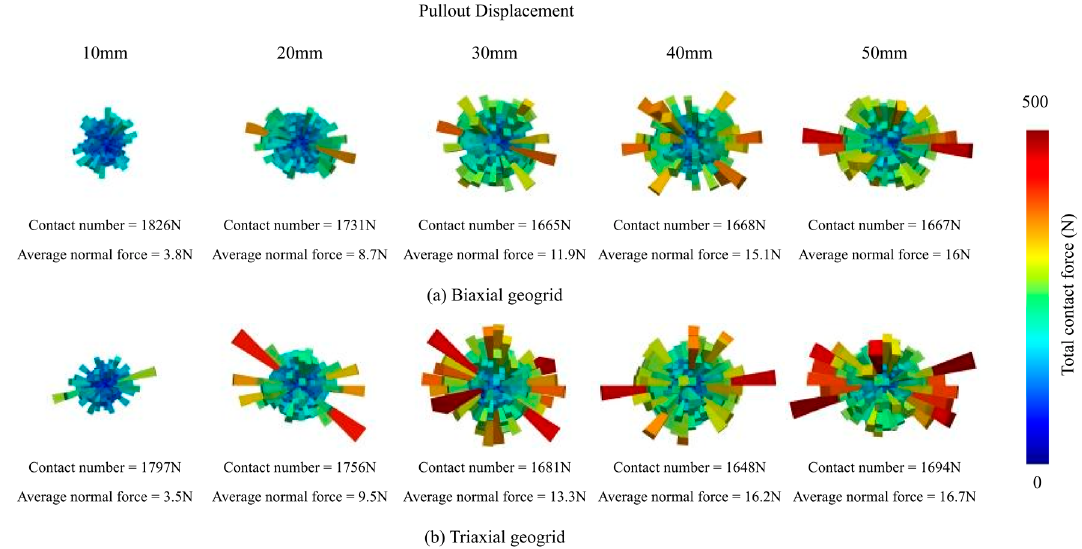
Figure 8. 3D contact force distribution of particles during pullout: ( a ) biaxial geogrid and ( b ) triaxial geogrid .